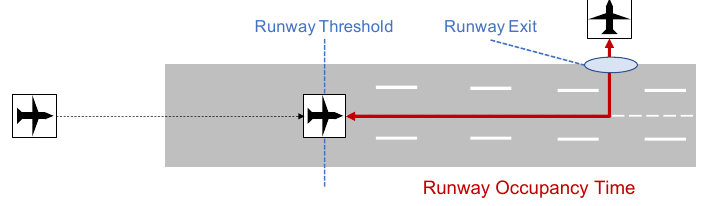
Figure 3. Runway Occupancy Time